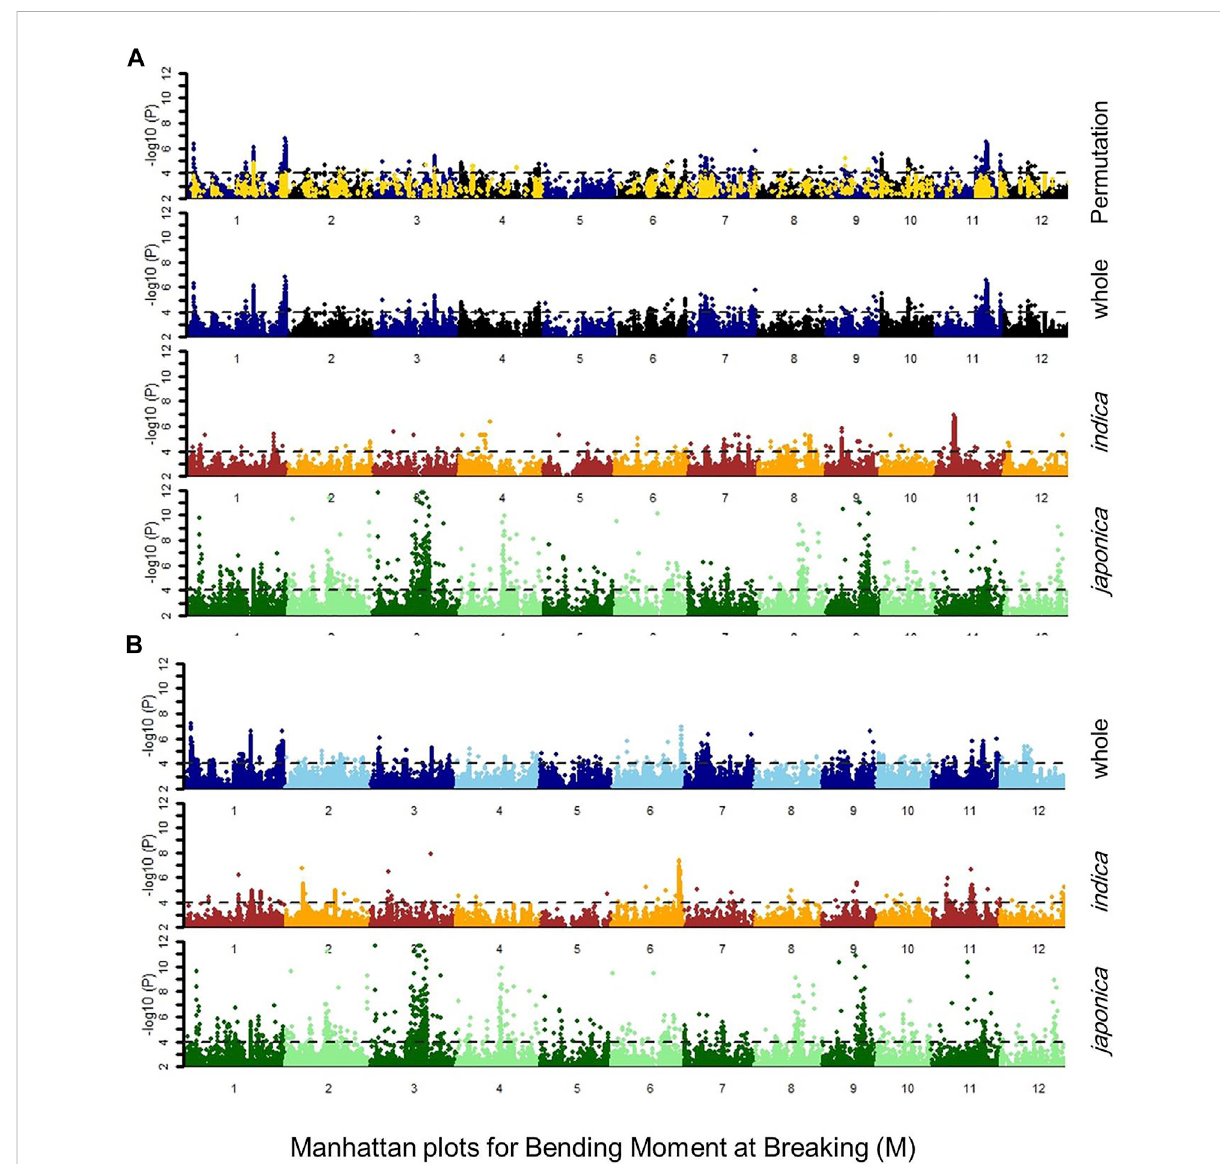
FIGURE 2 Manhattan plot for bending moment at breaking M, indicating the regression values for SNP markers in japonica, indica subpopulations, whole population, and whole population after 1000-times permutation with the (A) general linear model (GLM) and (B) compressed mixed linear model (cMLM), the dotted lines showed the threshold level at -log(P) ≥